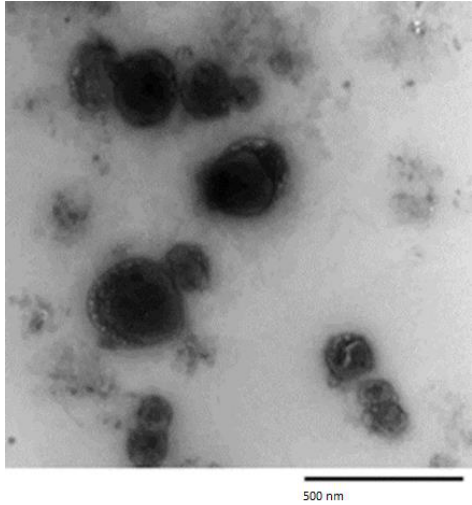
Figure 2. Transmission electron microscope (TEM) image of the optimized OL/NSs.